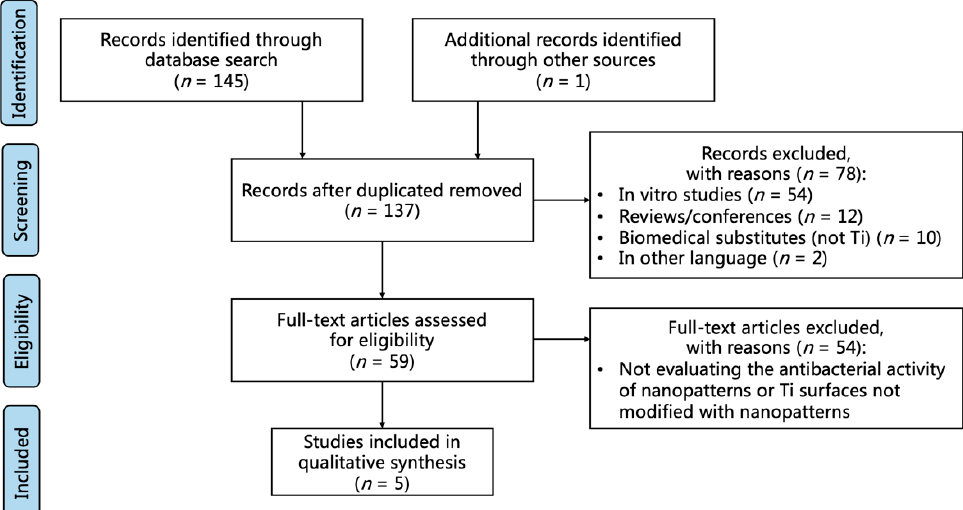
Figure 1. PRISMA (Preferred Reporting Items for Systematic Reviews and Meta-Analyses) diagram including study algo- rithm.